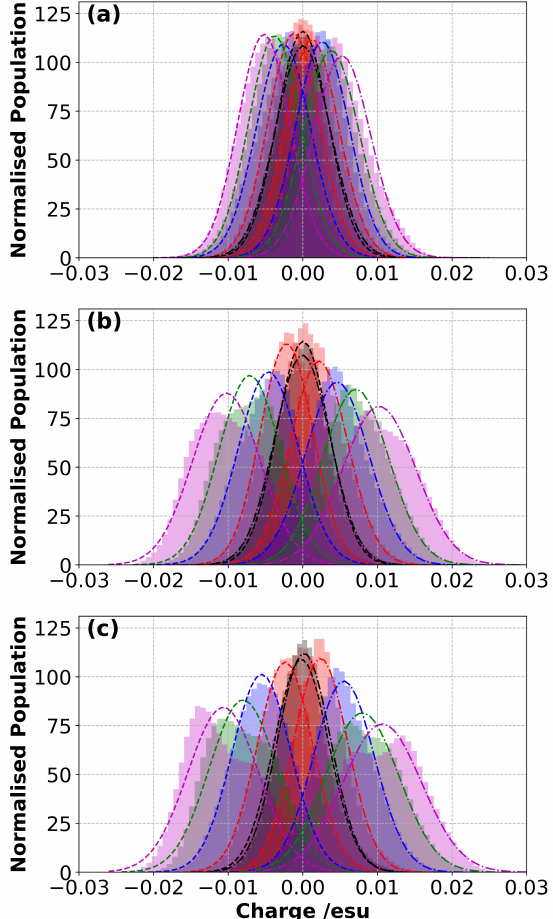
Figure 5. Probability distribution of partial atomic charges of the electrode atoms in response to ∆Ψ at ( a ) 300 K, ( b ) 400 K and ( c ) 500 K. Dashed lines represent the Gaussian fit curves. Colour scheme: black, red, blue, green and magenta for 0 V, 1 V, 2 V, 3 V and 4 V